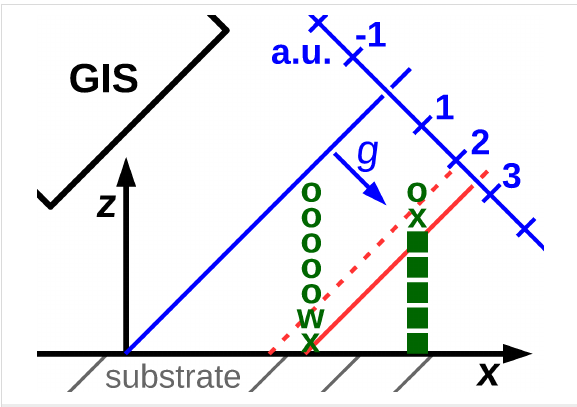
Figure 14: Working principle of the simple shadowing algorithm. A plane is defined parallel to the opening of the GIS needle (vector g ) and intersecting the coordinate system’s origin (blue line). In every preceding frame the maximum distance of all processed DEs is stored (red solid line). Only the deposition events farthest from the GIS needle within one frame within a small distance range, like 5 nm (dashed red line) are processed in a given frame. Filled squares repre- sent already deposited deposition events (DEs), ”x” are the DEs to be processed in the shown frame, ”o” are DEs too close to the GIS needle and ”w” are DEs not too close to the GIS but not reached by the corre- sponding edge in this